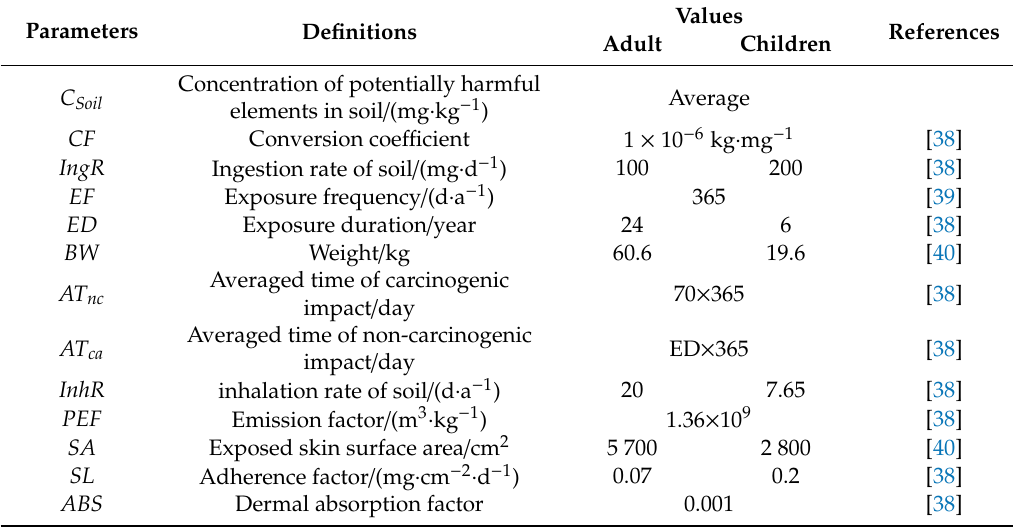
Table 1. Parameters used to evaluate exposure risks of soil